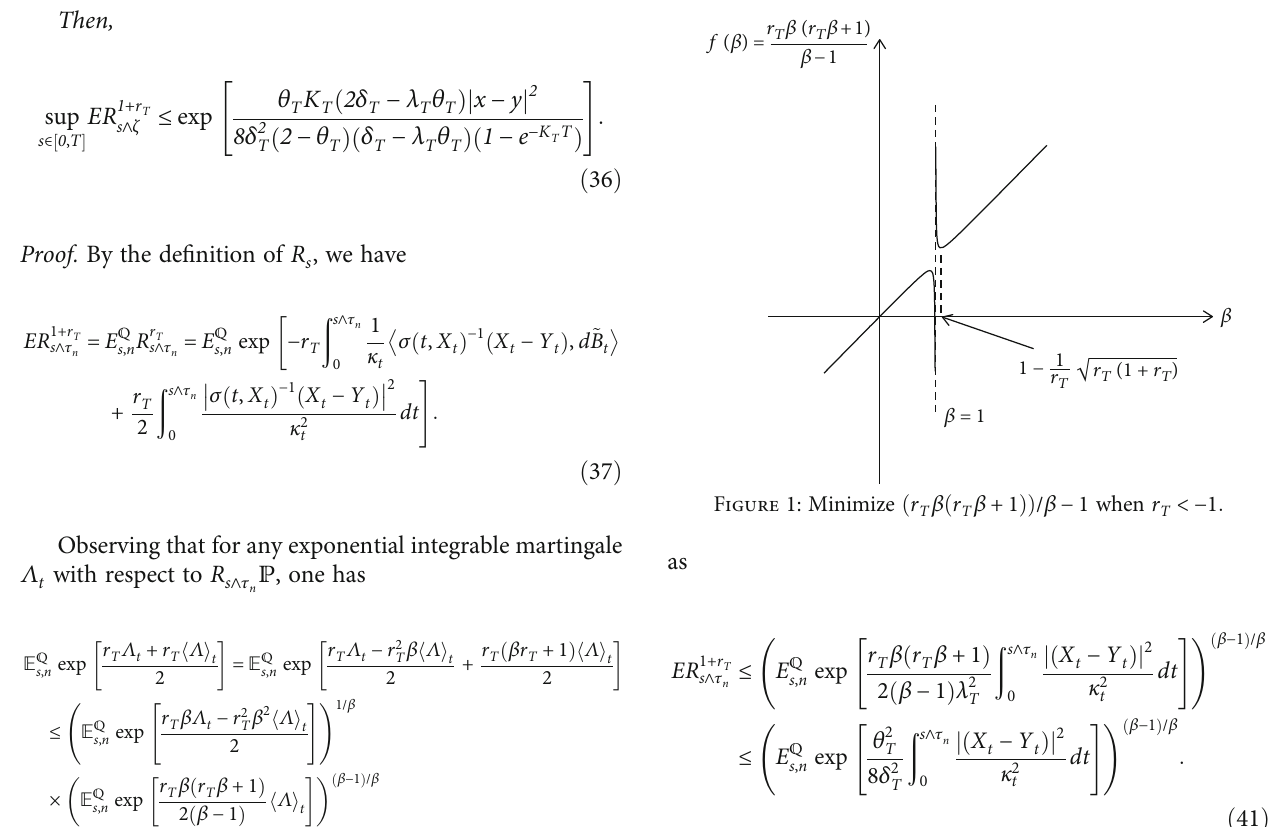
ffiffiffiffiffiffiffiffiffiffiffiffiffiffiffiffiffiffiffiffi r 1 + r T T ð ffiffiffiffiffiffiffiffiffiffiffiffiffiffiffiffiffiffiffiffi p r 1 + r T ð